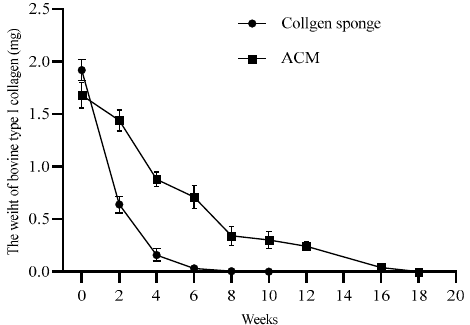
Figure 8. Degradation trend chart of collagen sponge and ACM in vivo